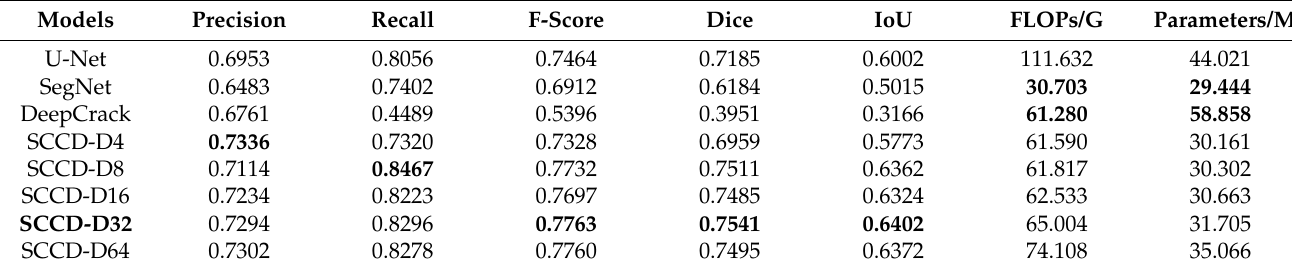
Table 1. Segmentation results of different models. The best scores are in